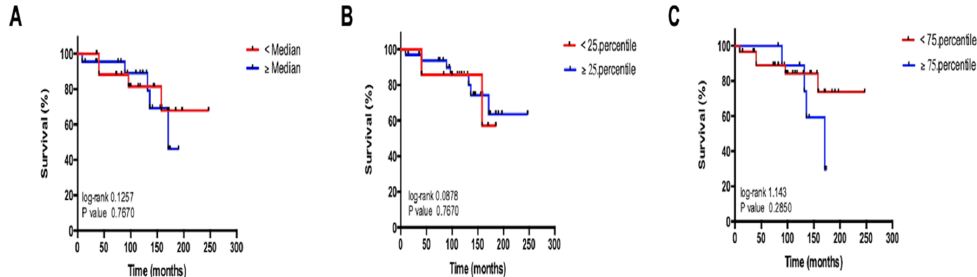
Figure 4. miR-29b expression is not associated with the patients’ prognosis. Kaplan–Meier analysis of serum miR-29b levels above (red curve) and below (blue curve) the ( A ) median (1.64 (AU)), ( B ) the 25th percentile (0.49 (AU)) and ( C ) 75th percentile (6.47 (AU)) of all miR-29b concentrations.